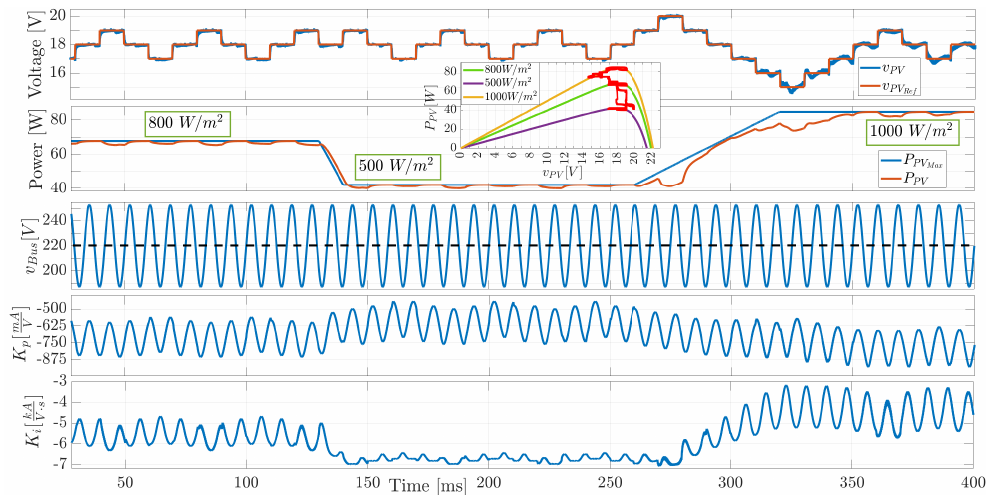
Figure 18. System performance for changes on the irradiance, MPPT action, and perturbation on the DC